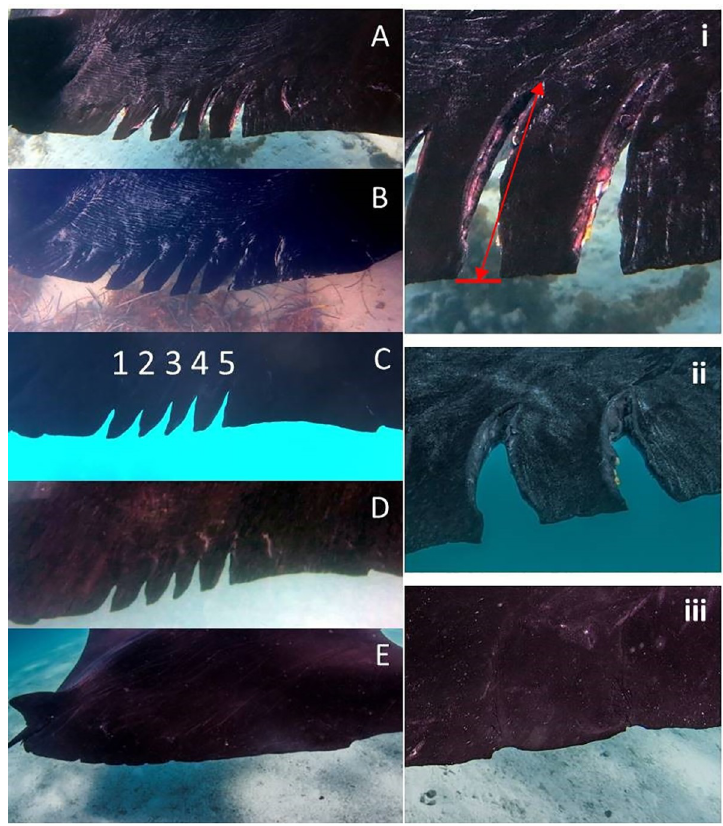
Fig 2. Images of the wounds from Days 0, 17, 33, 42 and 295 (A-E respectively) showing the fresh wound, incremental healing and near stable wounds on reef manta ray Mobula alfredi #0018. On the right are close up images of Day 0 (i) showing severed cartilage, Day 7 (ii) (time not used in calculations) showing the start of healing, and Day 295 (iii) showing near complete healing with concave scars. The red arrows in (i) indicate the protocol for measuring each wound where the distance from the top of the wound to the mid-point between the adjacent sides at the extremity was used to indicate wound length.